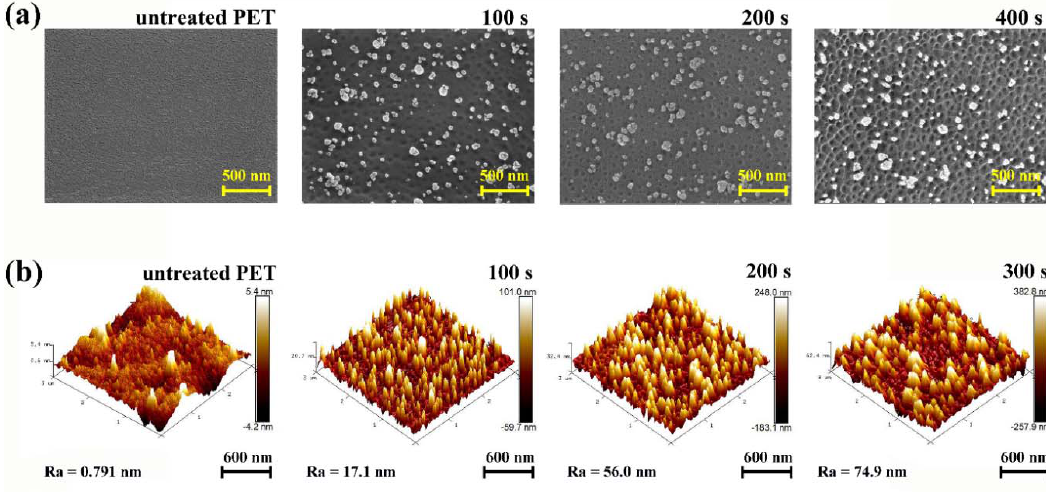
Figure 2. Morphological changes in nanostructured ‐ polyethylene terephthalate (PET): (a) Field ‐ Figure2. Morphologicalchangesinnanostructured-polyethyleneterephthalate(PET):( a )Field-emission emission scanning electron microscopy (FE ‐ SEM) images of untreated ‐ PET and nanostructured ‐ PET scanning electron microscopy (FE-SEM) images of untreated-PET and nanostructured-PET (oxygen (oxygen plasma treatment time from left 100, 200, and 400 s) and (b) Atomic force microscopy (AFM) plasma treatment time from left 100, 200, and 400 s) and ( b ) Atomic force microscopy (AFM) 3D 3D images of untreated ‐ PET and nanostructured ‐ PET (oxygen plasma treatment time from left 100, 200, and 300 s).